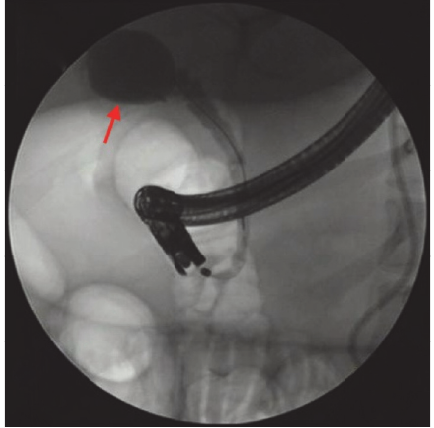
Figure 2: Preintervention MRCP revealing a nine-millimeter stone in the cystic duct (marked with arrow).